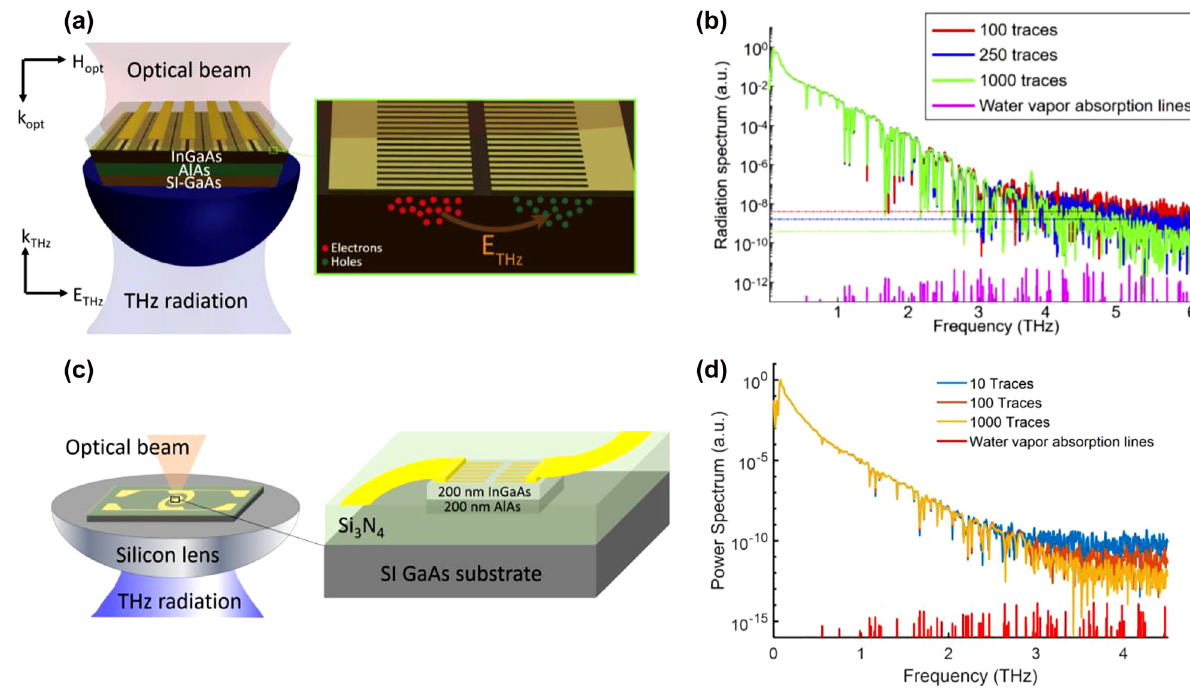
Figure 9: (a) Schematicdiagram and the (b) detected power spectra underdifferent number of averagedtraces for the 1040 nm detectorat an incidentaverageterahertzpowerof6.8µW.Reprintedbypermissionfrom[95].Copyright(2020)byTheOpticalSociety.(c)Schematicdiagram and the(d) detected powerspectra underdifferent numberof averagedtraces for the 1550nm detectorat an incident averageterahertzpower of 206 µW. Reprinted by permission from [96]. Copyright (2020) by The Optical Society.